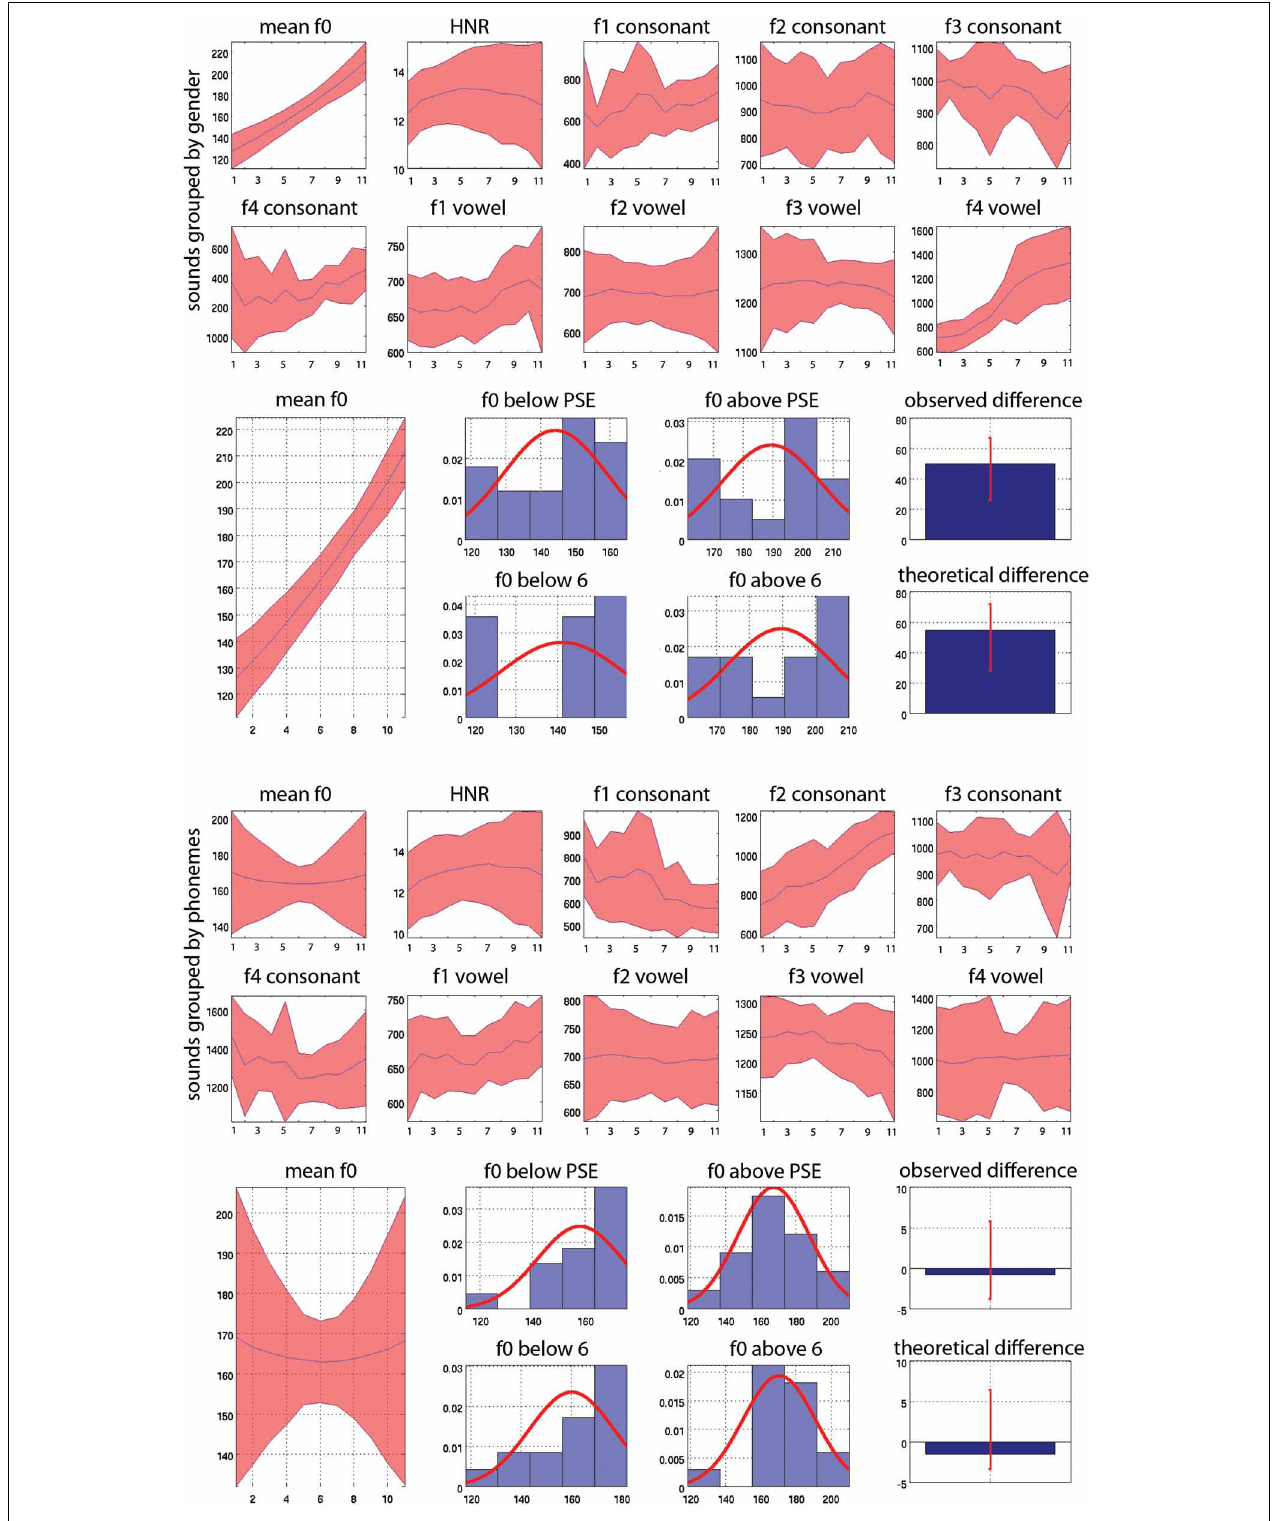
FIGURE 4 | Mean values and 95% CI of acoustic properties measured on whole sounds (f0 and HNR) and on consonants and vowels separately (f1, f2, f3, f4). At the top (1st and 2nd rows) the acoustic properties are averaged according to gender, averaging values across stimuli for each step